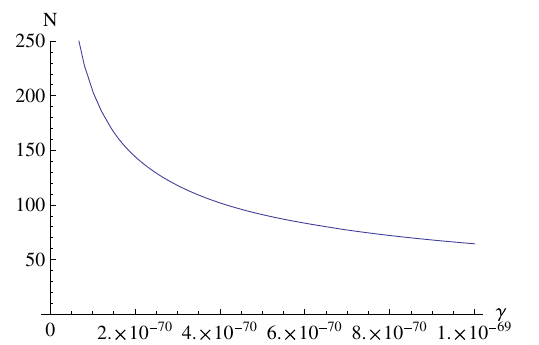
Fig. 9 The diagram presents the relation between the number of e- folds N and the parameter γ . The parameter γ is given in s 2 Mpc 2 assume that δ = 0 and the inflation time is of order 10 − 32 s [38]